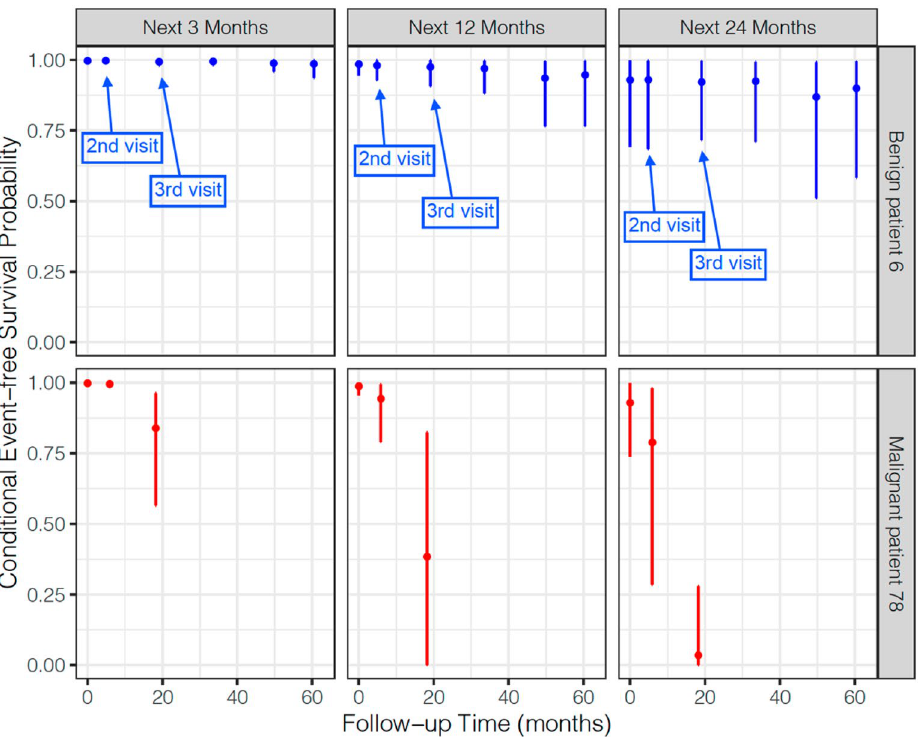
Figure 4. Conditional event-free survival (probability) with 95% confidence intervals for the benign patient 6 (top panels) and the malignant patient 78 (bottom panels) at t + 3 (left panels), t + 12 (middle panels), and t + 24 months (right panels), where t represents follow up visits. In this example, benign patient 6 had six visits and malignant patient 78 had three visits.